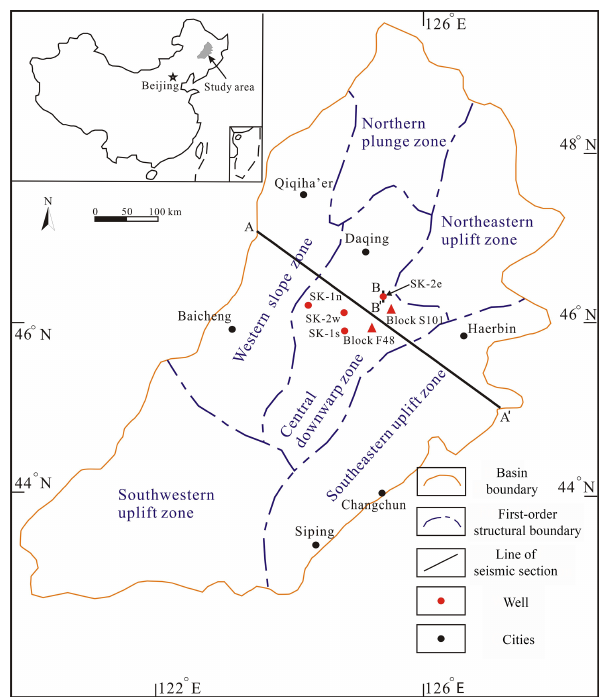
Figure 18. Tectonic scheme of the Songliao Basin with the location of SK-1 and SK-2 boreholes. The tectonic scheme is according to Zhou and Littke (1999). SK-1s and SK-1n are the north and south hole sites of SK-1, respectively, while SK-2e and SK-2w are the east and west hole sites of SK-2, respectively. A–A (cid:48) : the SE–NW cross-seismic